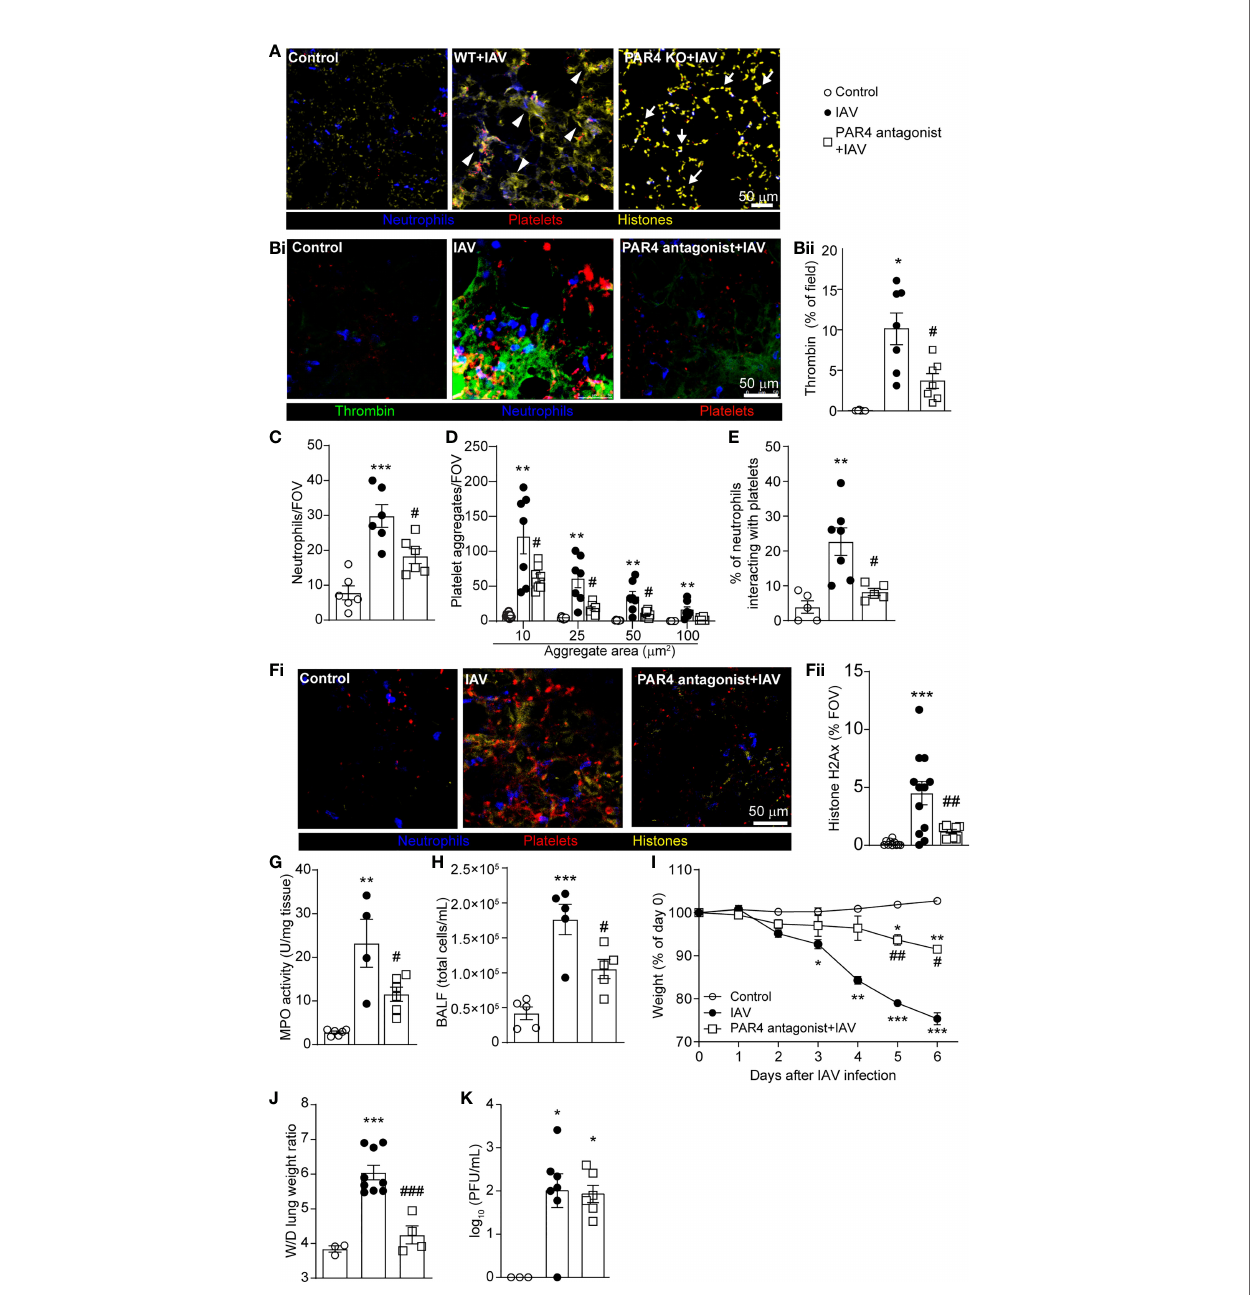
FIGURE 5 | PAR4 Drives IAV-Induced In fl ammation and Subsequent Tissue Damage. (A) Representative immunostaining of WT lung tissue uninfected control and WT and PAR4 KO (PAR4 -/- ) mice 5d after IAV infection (neutrophils, blue; histone, yellow; platelets, red). Arrowheads denote diffuse, intravascular histone staining (NETs), and full arrows indicate punctate, nuclear histone stain. (Bi) Representative IVM image of lungs of control (uninfected) and 5d post IAV infection of control and PAR4 antagonist (TcY-NH 2 )-pretreated mice demonstrating intravascular thrombin activity (neutrophils, blue; platelets, red; thrombin activity, green). (Bii) Quanti fi cation of thrombin activity measured as a % of the FOV labelled by the fl uorescent substrate in uninfected control, IAV-infected control and PAR4 antagonist pretreated animals. Quanti fi cation of neutrophils (C) , platelet aggregation (D) , platelet-neutrophil interactions expressed as a % of neutrophils contacting platelets (E) in IAV-infected control and PAR4 inhibitor (TcY-NH 2 ) pretreated mice. (Fi) Representative IVM image of lungs of control (uninfected) and 5d post IAV infection of control and PAR4 antagonist (TcY-NH 2 )-pretreated mice demonstrating histone staining (neutrophils, blue; histone, yellow; platelets, red). Quanti fi cation of extracellular histone (Fii) , lung MPO activity (G) , BALF cellularity (H) , animal body mass (I) , lung wet-to-dry tissue weight ratios (J) , and viral loads (K) in IAV-infected control and PAR4 inhibitor (TcY-NH 2 ) pretreated mice. Values represent the mean +/- SEM. n = 4-12 per group. *p < 0.05, **p < 0.01, ***p < 0.001 compared to the control group. # p < 0.05, ## p < 0.01, ### p < 0.001 compared to the IAV-infected